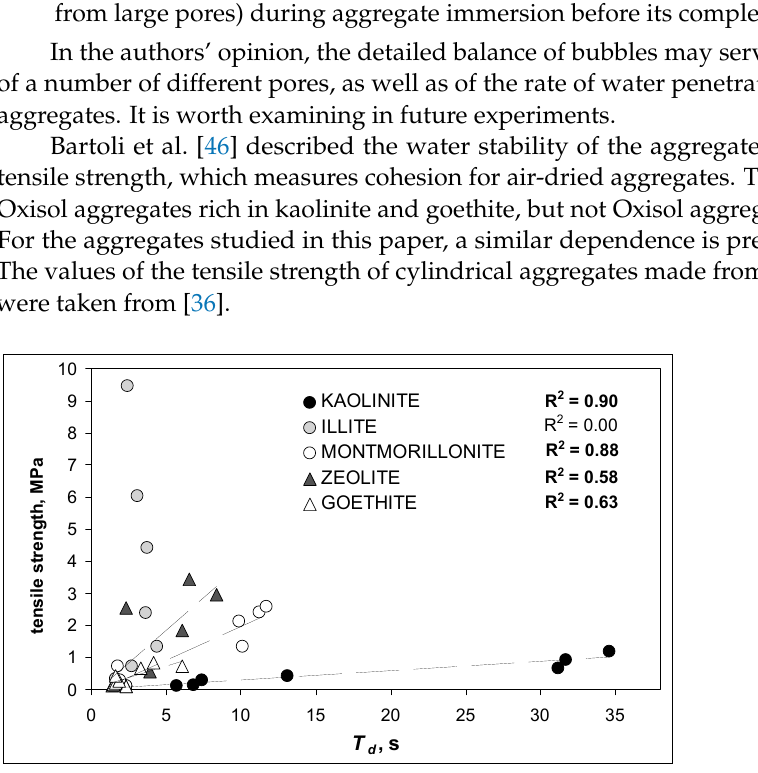
Figure 11. Correlations between time necessary for complete destruction of the unit aggregate surface ( T d ) and tensile strength. R 2 are linear regression coefficients.